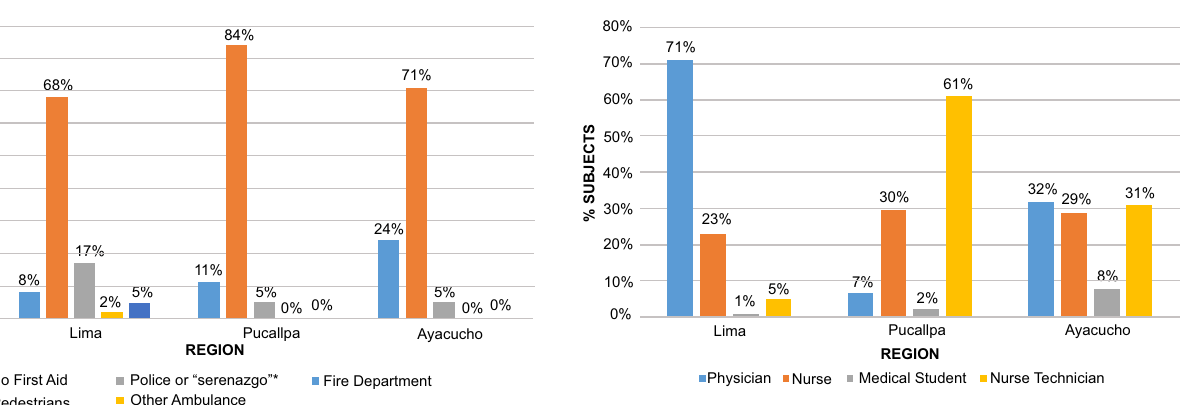
Figure 2. Profile of individuals that provided initial care during the pre-hospital period, by city. There were a total of 644 patients. * Serenazgo : municipal patrol guards.